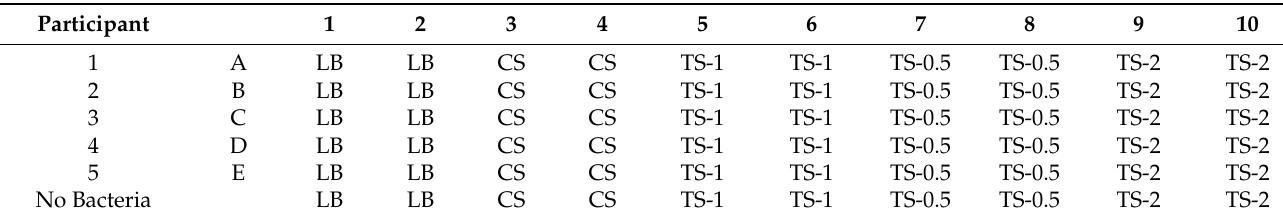
Table 2. Layout of the microtiter plate for absorbance analysis. 100 µ L was removed from each culture and added to wells in the same organization as above, with the exception of the last row which contained the treatments alone in LB. Duplicate samples were taken from each culture.